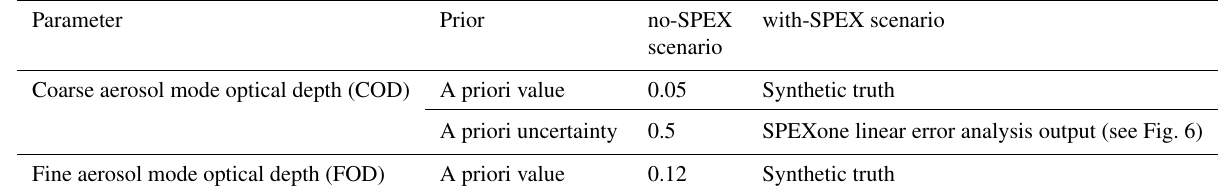
Table 3. Summary of no-SPEX and with-SPEX design scenario assumptions.